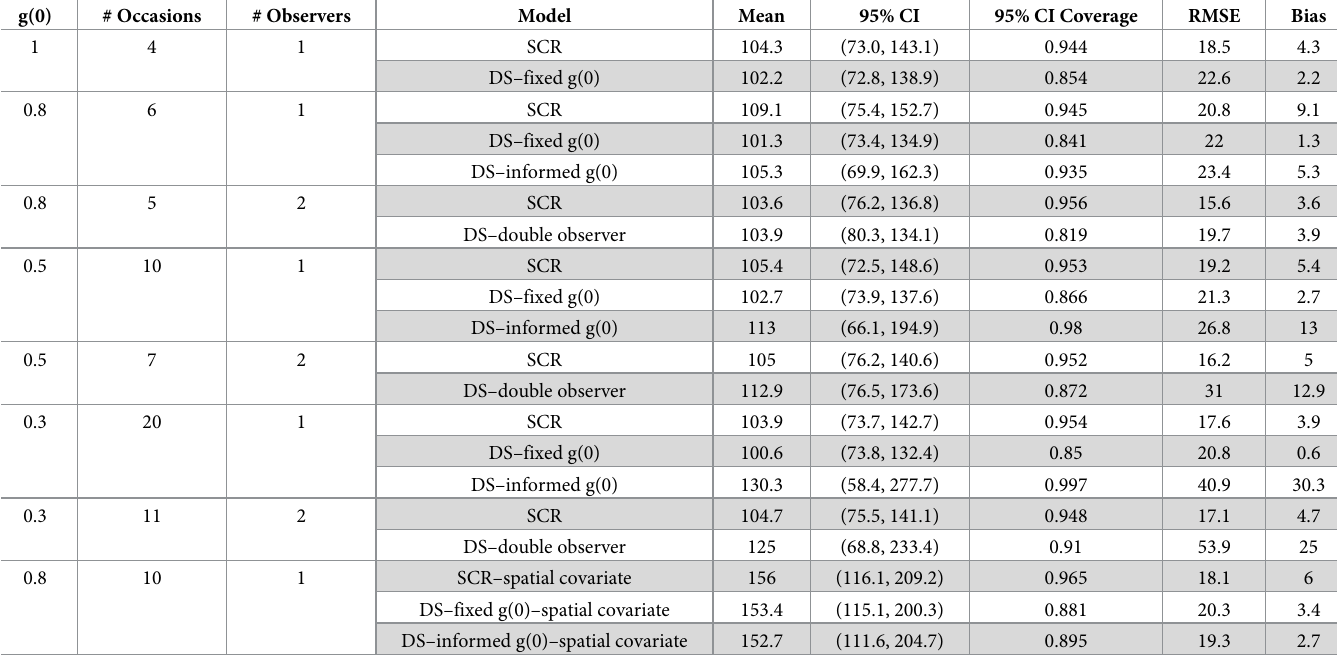
Table 1. Simulation